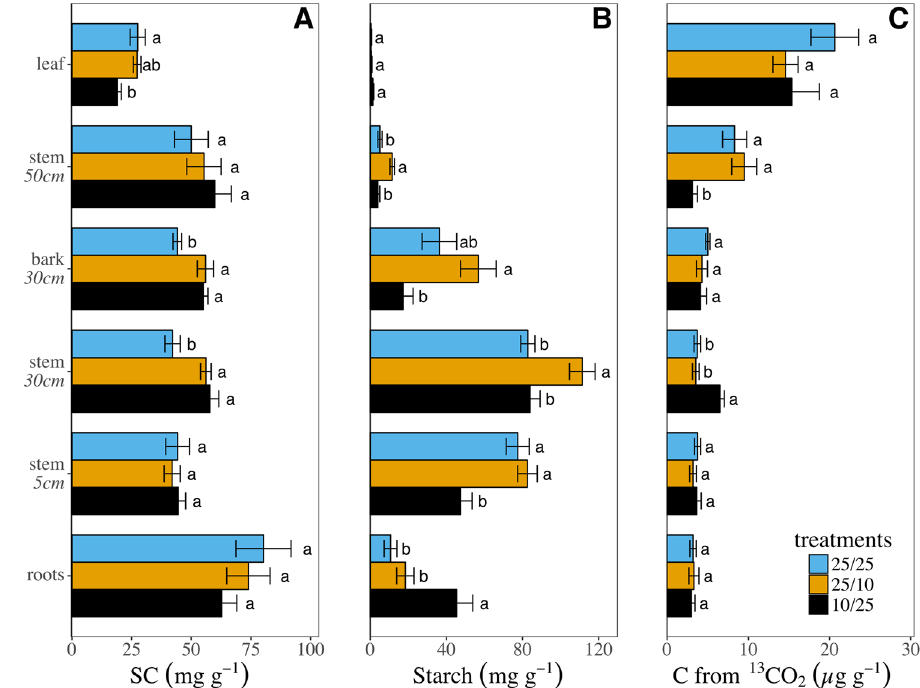
Figure 2. Impact of temperature gradients on nonstructural carbohydrates redistribution in young trees. ( A ) Soluble carbohydrates (SC), ( B ) starch, and ( C ) C derived from 13 CO 2 levels in the leaves, bark at 30 cm from soil, stem at 50, 30, and 5 cm above soil, and roots control trees (25 °C shoot /25 °C root , light gray columns), simulated spring (25/10, gray columns), or simulated fall (10/25, dark gray columns). Error bars denote standard errors and lowercase letters denote statistical differences (two-ways Anova and Tukey-HSD, P < 0.005, df =